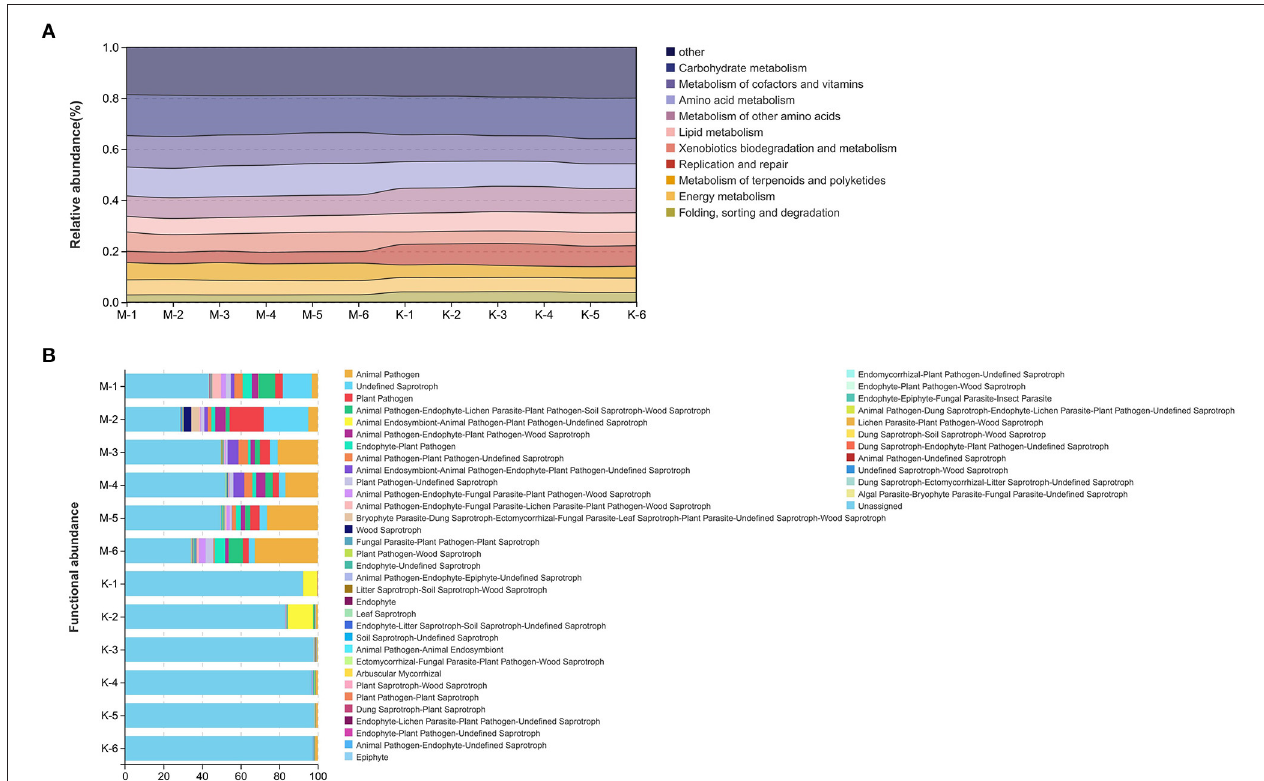
FIGURE 6 | Functional predictive analysis of bacteria and fungi. (A) Based on PICRUSt functional prediction, the obtained KEGG functional abundance of sample bacteria was displayed using a river map. (B) Based on the information in the OTU abundance table, further functional annotation of fungi was performed using